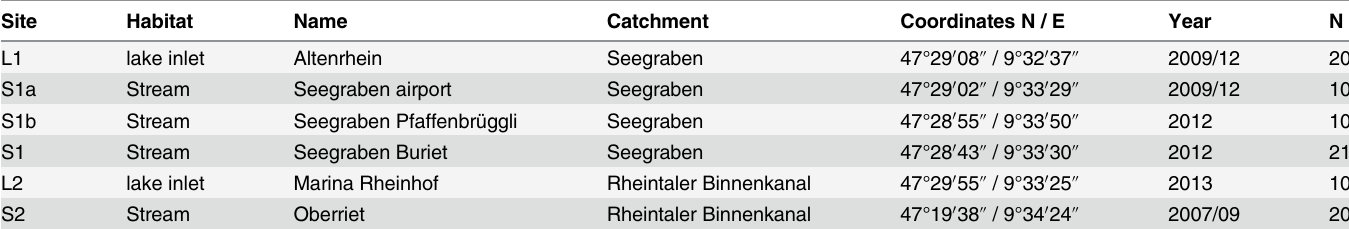
Table 1. Sampling site